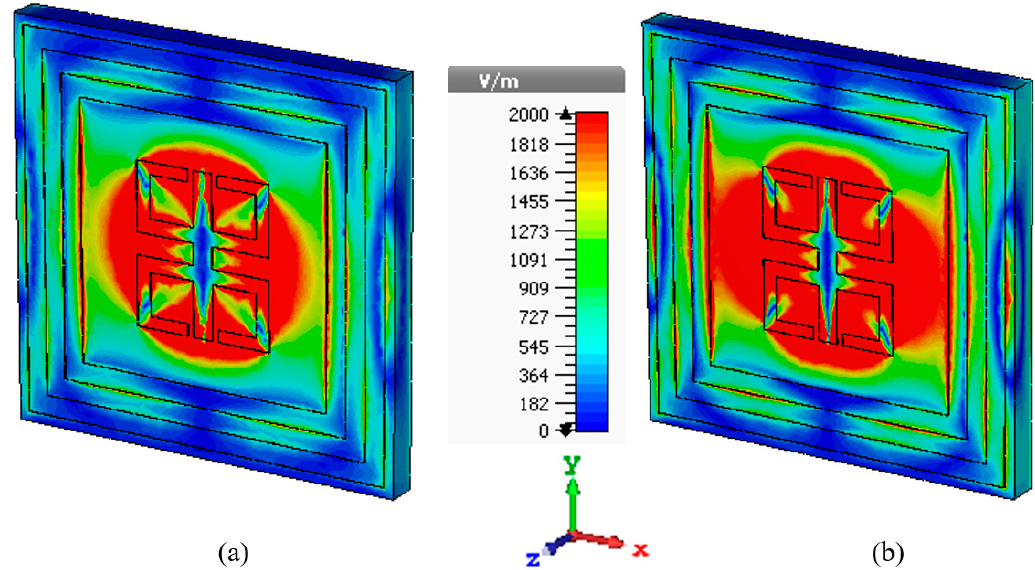
Figure 3. E-field distribution at the resonance frequency ( a ) 13.78 GHz, ( b ) 15.3 GHz of proposed MM absorber.